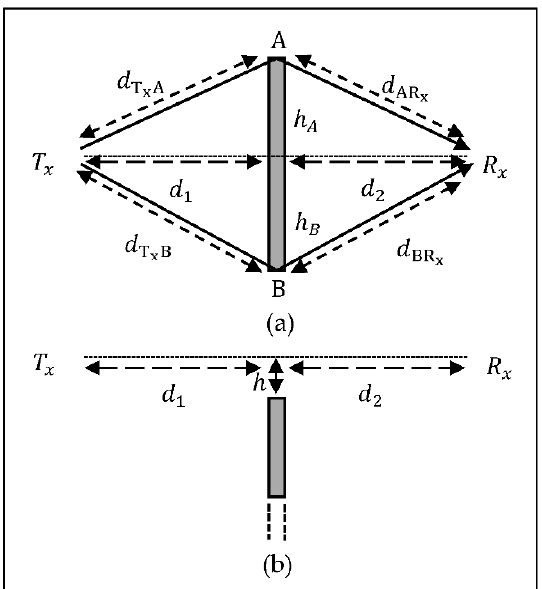
Figure 5. ( a ) The double knife-edge diffraction (DKED) model (top-view); ( b ) Half-plane absorbing screen.